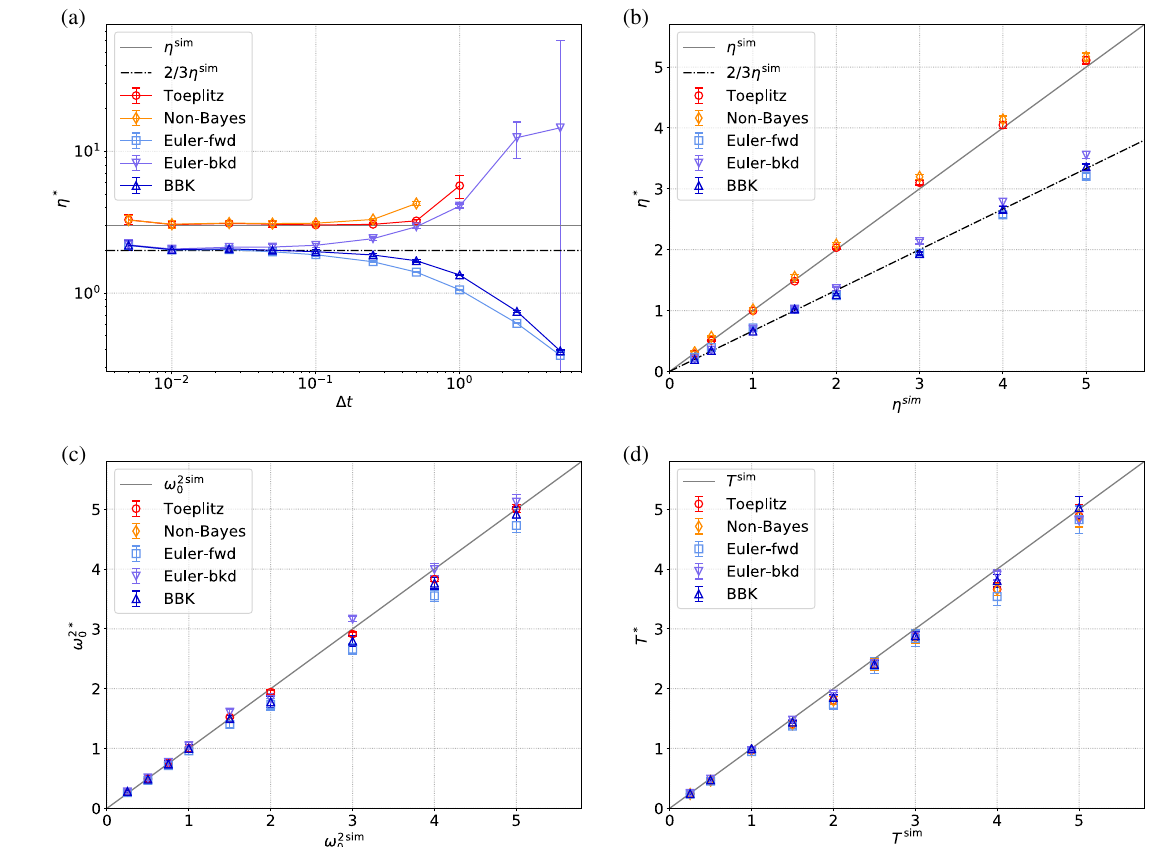
FIG. 1. Inference results for the stochastic harmonic oscillator. Sample trajectories are obtained from exact numerical integration of the set of first-order equations with parameters η sim , ω sim 0 , and T sim . The simulation time step τ sim is always equal to 0.005, and it corresponds to the minimum displayed value of Δ t in (a). Points at higher values of Δ t are obtained by applying the inference procedure to subtrajectories extracted from the original one. Each of the points displayed in (b) – (d) is obtained as a weighted average of the inference results for different Δ t values in the range where the small Δ t approximation is valid. Weights correspond to the squared inverse of the error bars, displayed in (a) for the η parameter. We compare the accuracy of all the schemes derived in Appendix B from a first-order Taylor-Itô expansion (Euler-fwd, Euler-bkd, and BBK) and from a second-order expansion (Toeplitz and non-Bayes). (a) Inferred values for the damping coefficient of the harmonic oscillator, η (cid:3) . Averages over ten sample trajectories of 5000 points (for any Δ t ) are reported with their 0.95 CI. Simulation parameters: T ¼ 1 , ω 0 ¼ 1 , and η ¼ 3 . (b) Inferred damping coefficient η (cid:3) vs true simulation parameter η sim : Results from higher-order methods follow the line of slope 1, whereas numerical results from naïve methods fall on the line of slope 2 = 3 . The remaining parameters are fixed: T ¼ 1 and ω 0 ¼ 1 . (c) Inferred squared frequency of the harmonic oscillator ω 2 0 (cid:3) vs true simulation parameter ω 2 0 sim . All the schemes give correct results in this case in the whole explored range of values. Simulation parameters: η ¼ 3 and T ¼ 1 . (d) Inferred temperature T (cid:3) vs the true value of the simulation parameter T sim : Again, results from all schemes fall on the line of slope 1 in the whole explored range of values. Remaining simulation parameters: η ¼ 1 . 5 and J ¼ 1